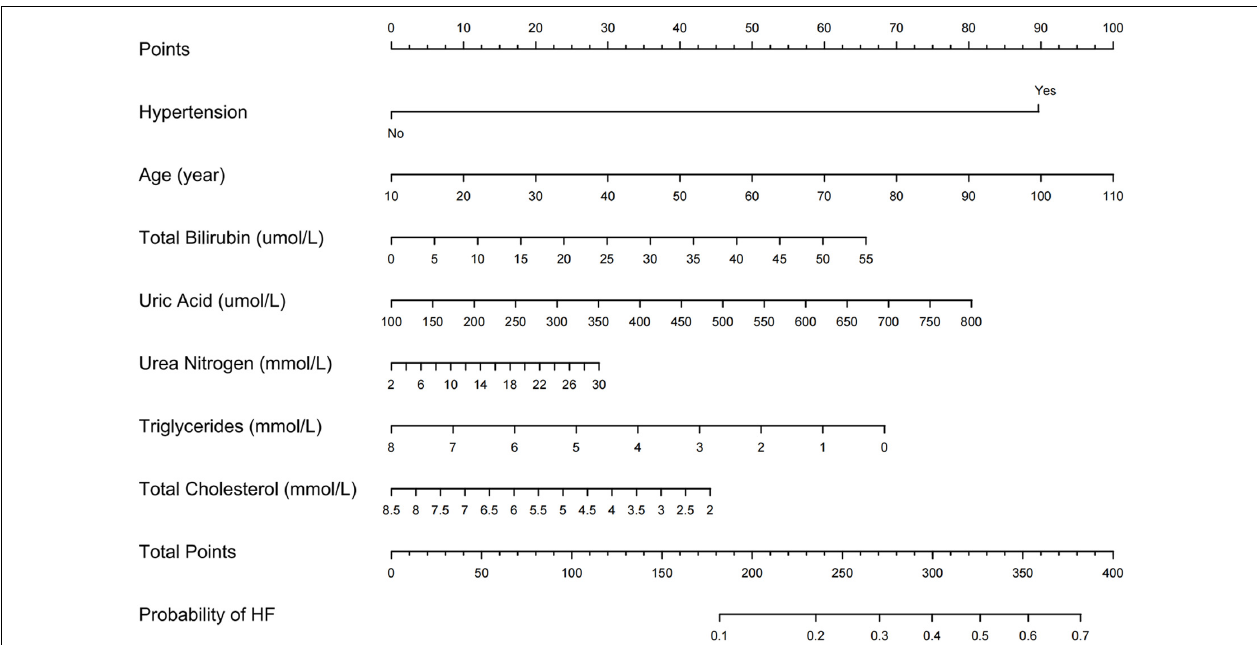
FIGURE 2 | Nomogram predicting HF in patients with CHD.